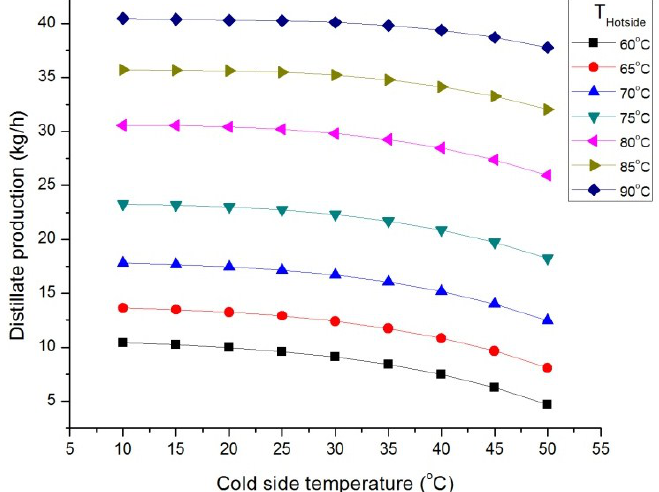
Figure 11. The distillate productivity improves with increase in hot side temperature and decrease in cold side temperature. Maximum distillate productivity of a two-stage system is 41 kg/h with hot side temperature of 90 °C and cold side temperature of 10 °C. Figure 11. Distillate production for variation in hot and cold side temperatures.